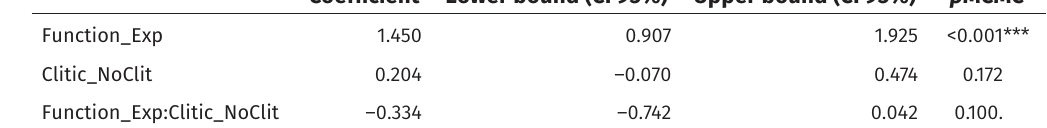
Table 2: Study 1 – Generalized linear mixed model fitted by using Markov chain Monte Carlo techniques (Hadfield 2010) with Gaussian family. Coefficient Lower bound (CI 95%) Upper bound (CI 95%)